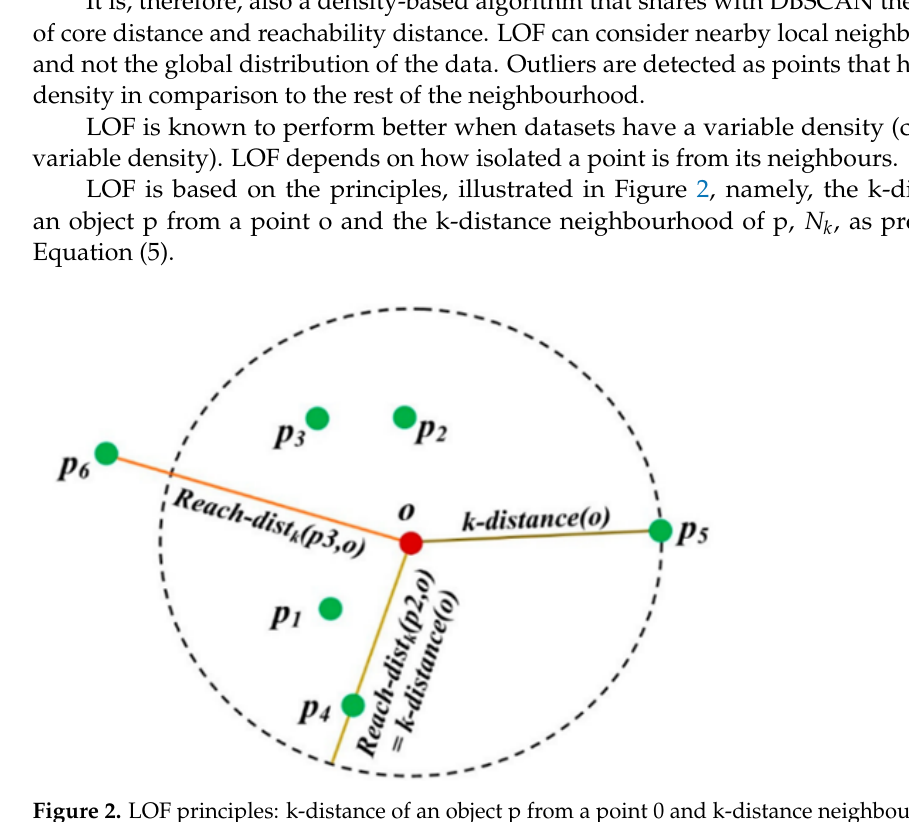
Figure 2. LOF principles: k-distance of an object p from a point 0 and k-distance neighbourhood of p, N k , and range distance (rdist)